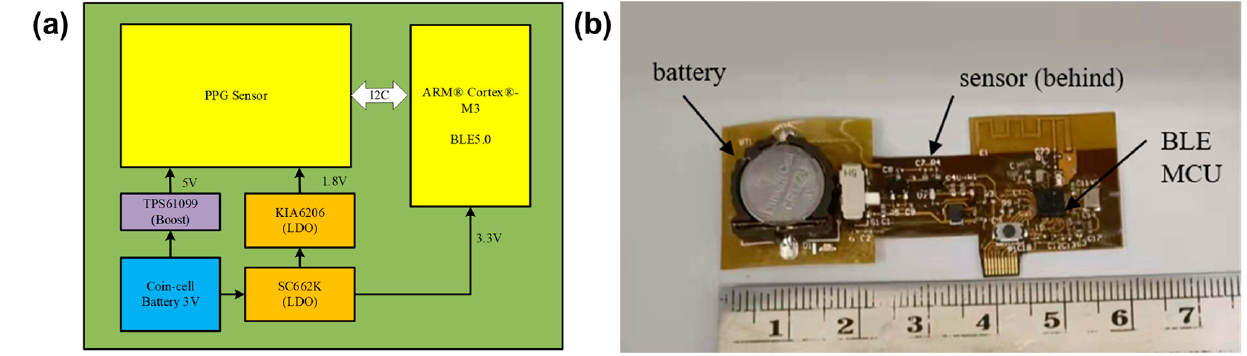
Figure 1. Circuit architecture of the smart ring for the apnea diagnosis ( a ), Photo of the fabricated FPC circuit board ( b ).